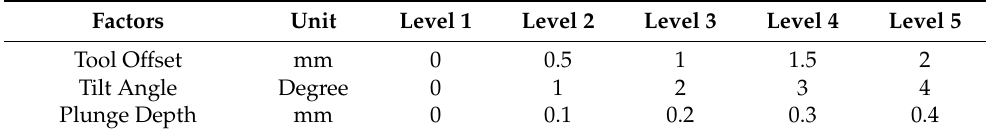
Table 4. Considered variables and their level.